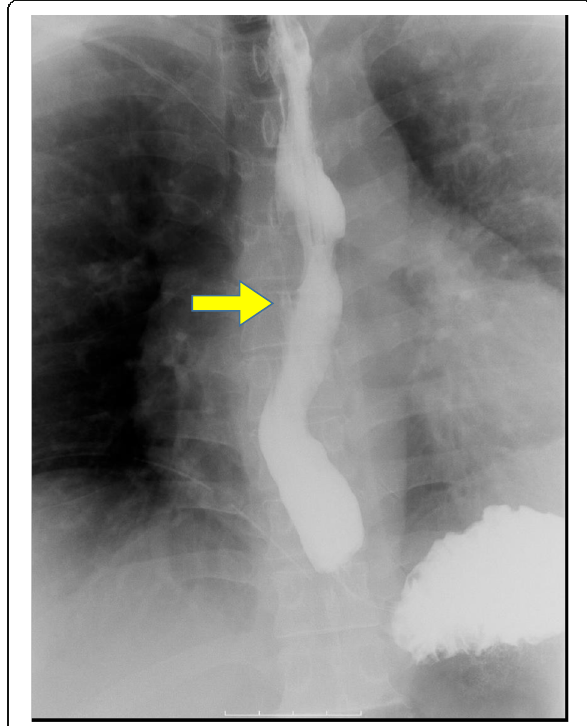
Fig. 4 A postoperative upper gastrointestinal contrast examination revealed no abnormalities